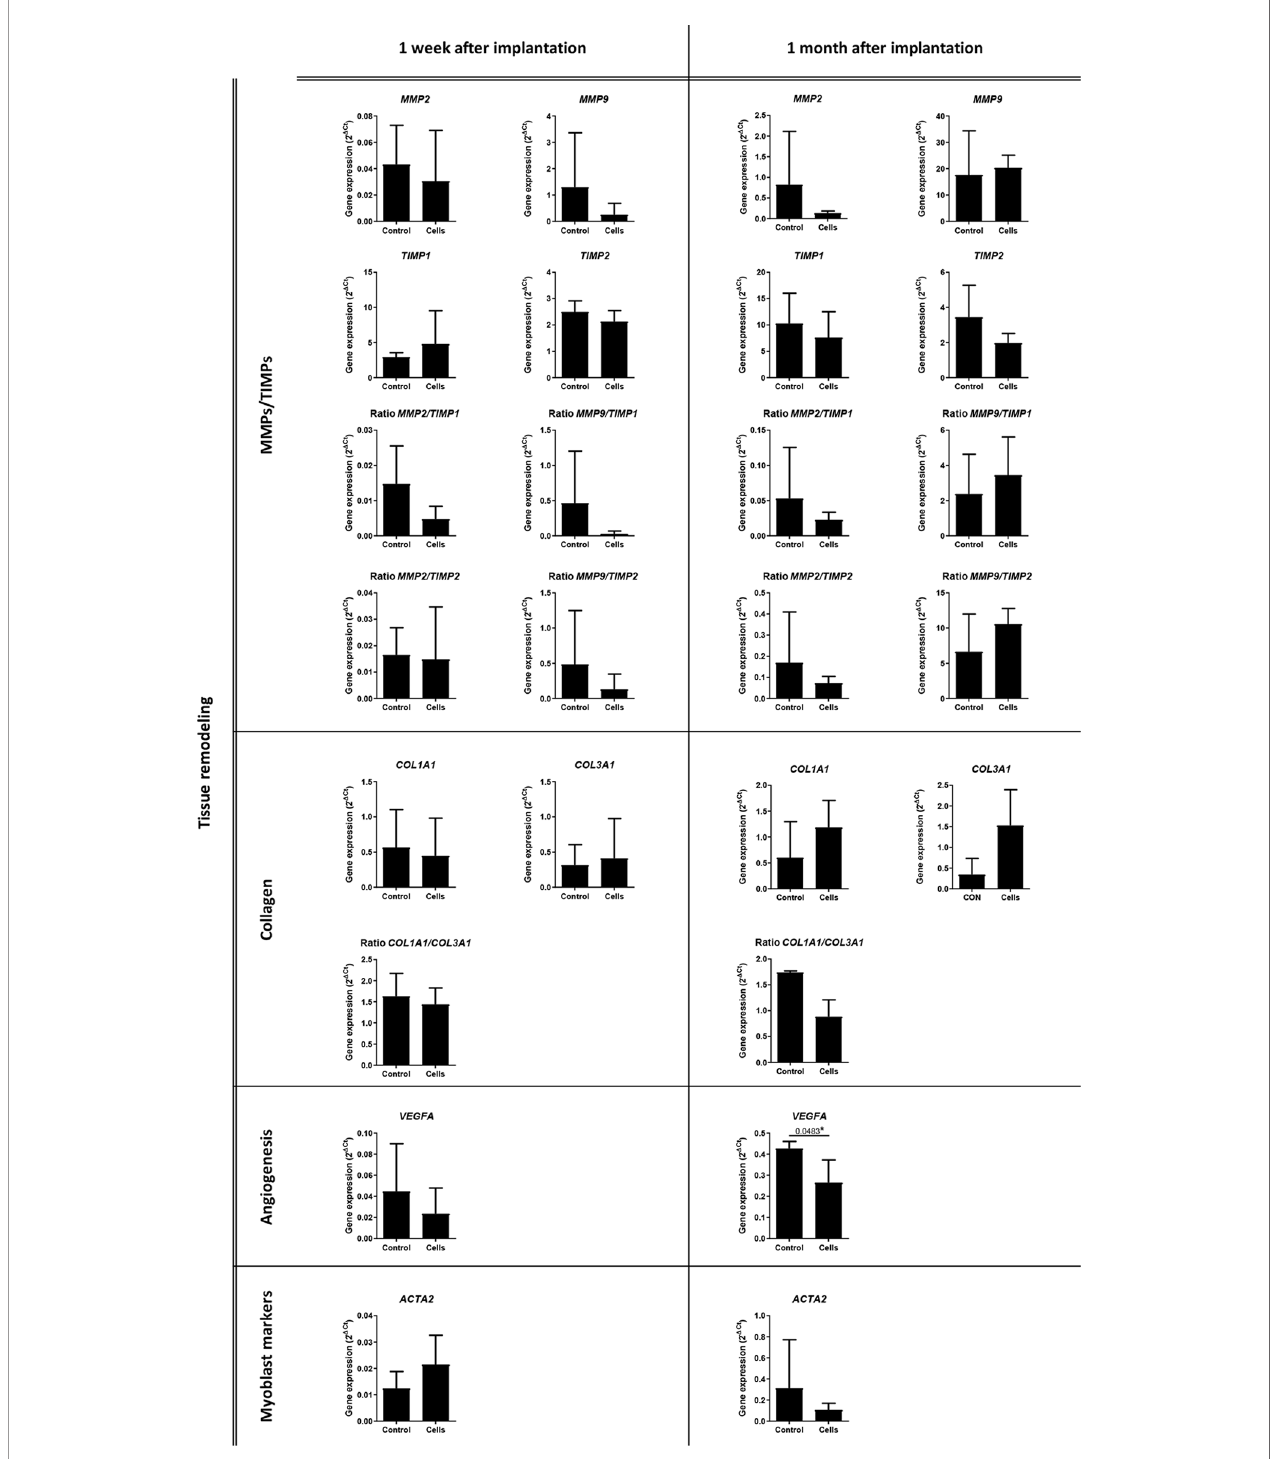
FIGURE 9 | Analysis of the expression of tissue remodeling-related genes. Quantitative real-time polymerase chain reaction was performed on the in fi ltrated cells within the surgical meshes 1 week and 1 month after mesh implantation. All the data are presented as mean ± standard deviation. The graphs were created with GraphPad Prism. * p < 0.05 refers to the control group. ACTA2, Actin Alpha 2, Smooth Muscle; COL1A1, Collagen Type I Alpha 1 Chain; COL3A1, Collagen Type III Alpha 1 Chain; MMP2, Matrix Metallopeptidase 2; MMP9, Matrix Metallopeptidase 9; TIMP1, TIMP Metallopeptidase Inhibitor 1; TIMP2, TIMP Metallopeptidase Inhibitor 2; VEGFA, Vascular Endothelial Growth Factor